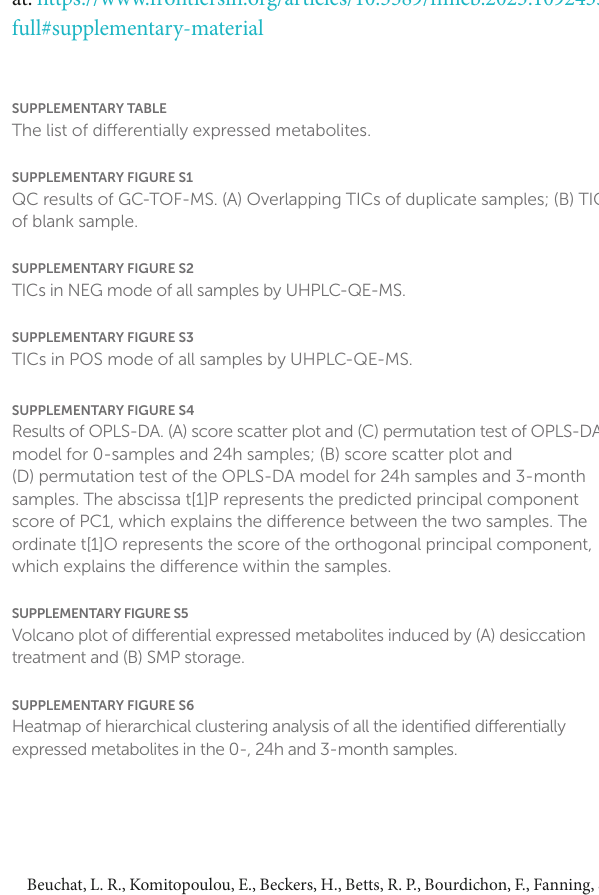
SUPPLEMENTARY TABLE The list of differentially expressed metabolites. SUPPLEMENTARY FIGURE S1 QC results of GC-TOF-MS. (A) Overlapping TICs of duplicate samples; (B) TIC of blank sample. SUPPLEMENTARY FIGURE S2 TICs in NEG mode of all samples by UHPLC-QE-MS. SUPPLEMENTARY FIGURE S3 TICs in POS mode of all samples by UHPLC-QE-MS.